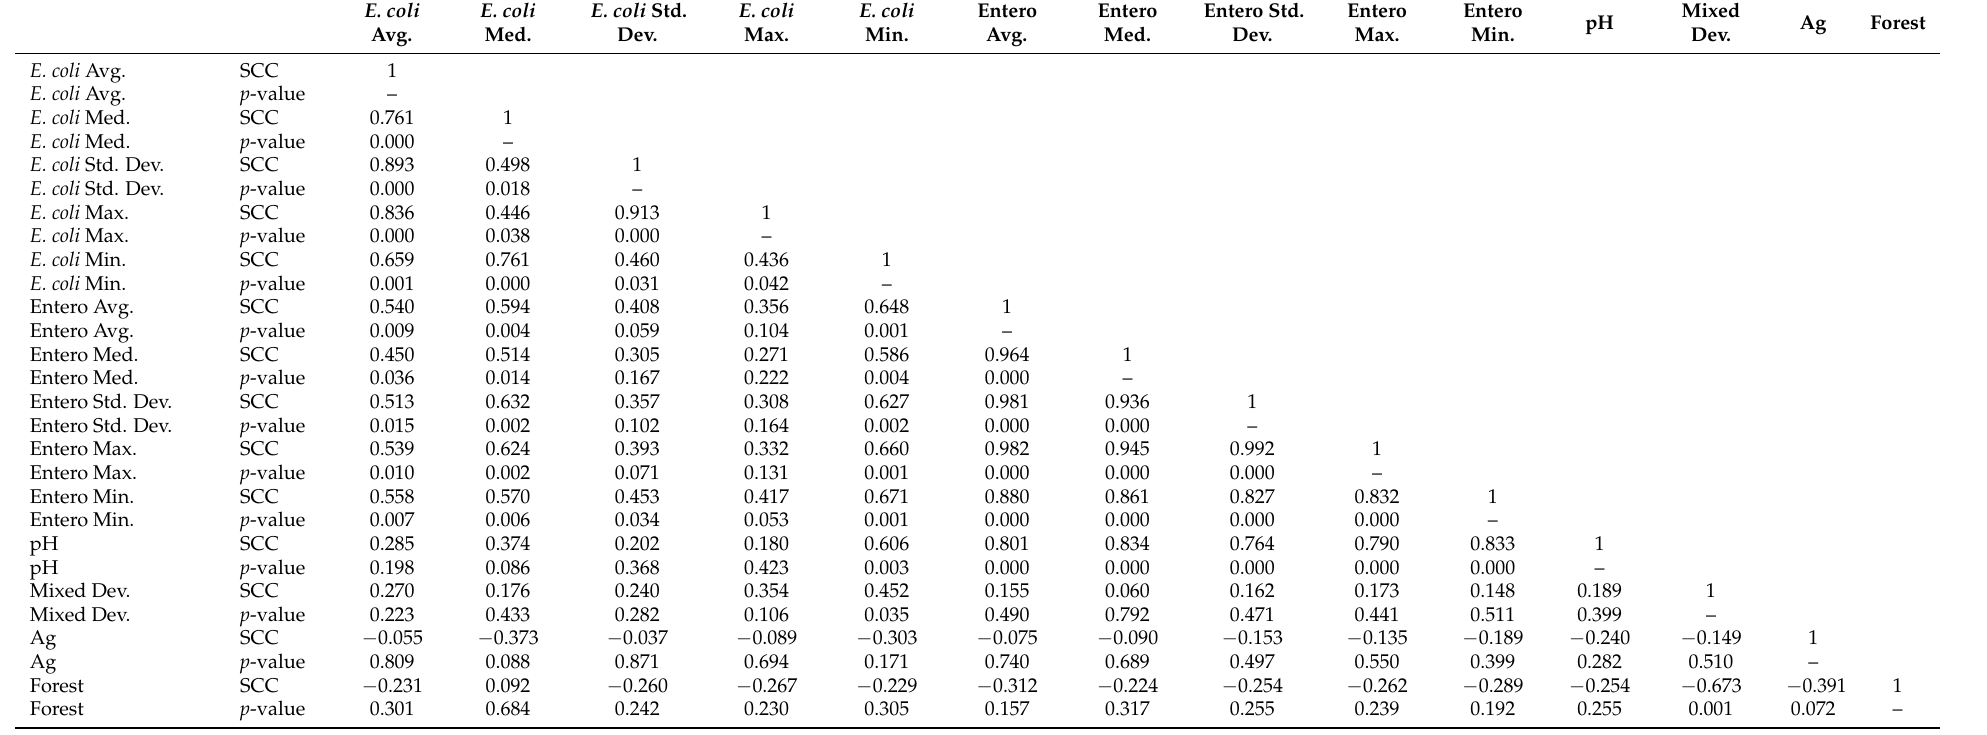
Table A3. Results of Spearman correlation tests of E. coli and enterococci results, pH, and land use/land cover metrics for each sampling location ( n = 22) during the study period (3 March–3 November 2020) in West Run Watershed, Morgantown, WV, USA. E. coli Avg.